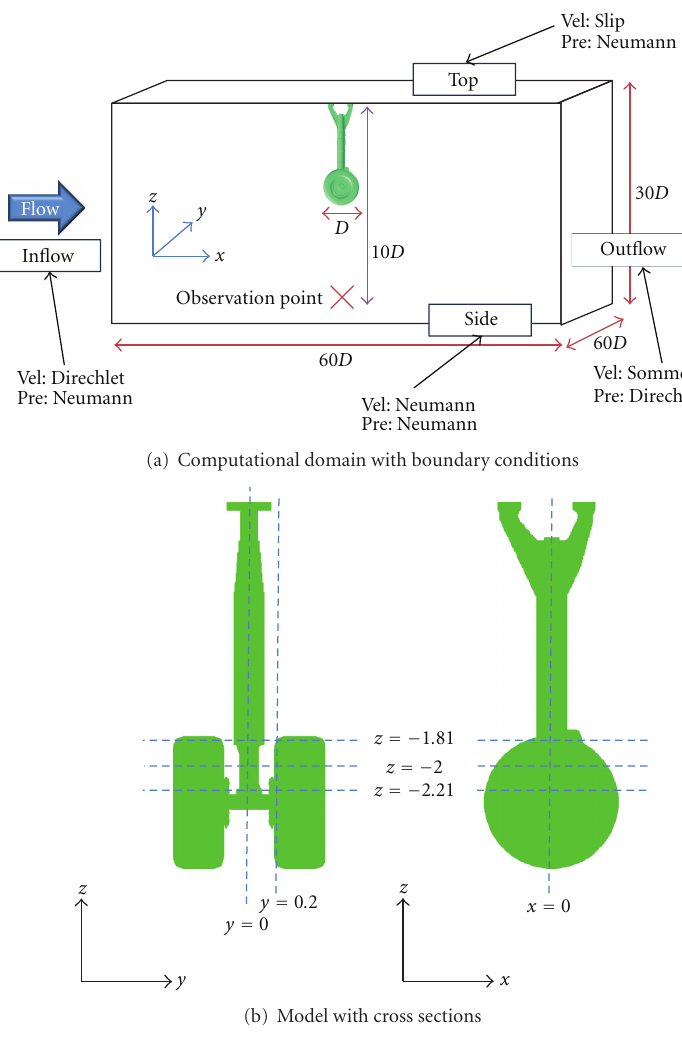
Figure 6: Computational domain and model cross